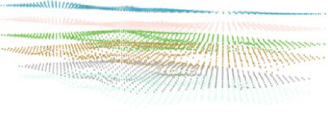
Figure 14. Stratum point model.